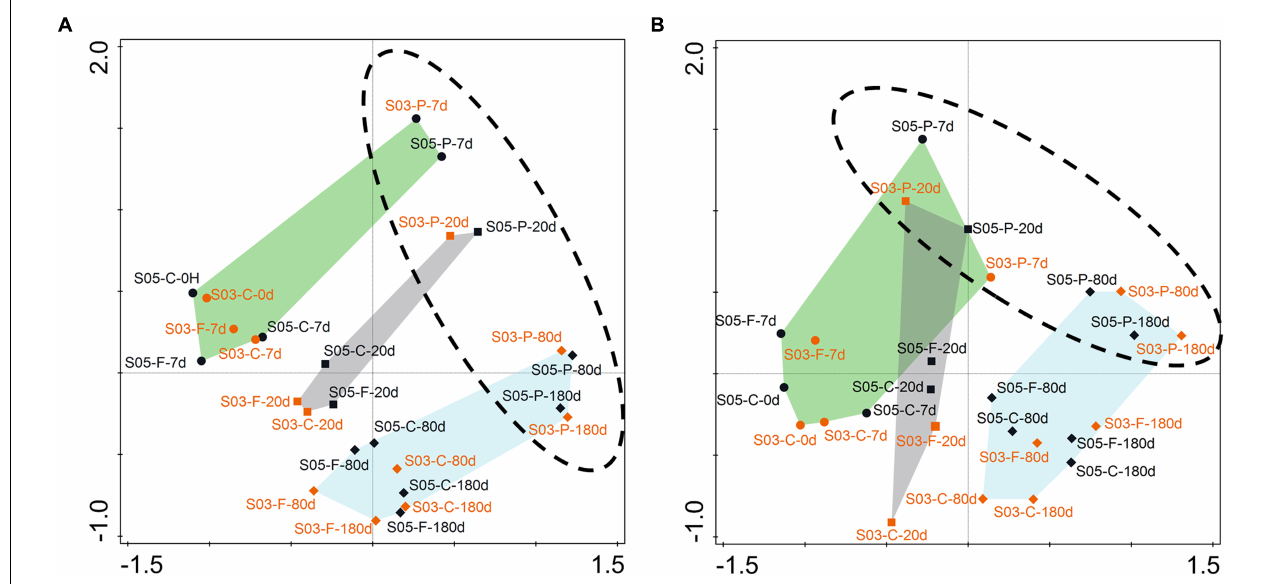
FIGURE 5 | Non-metric multidimensional scaling (NMDS) ordination based on Bray–Curtis similarities between microbial communities at the two-station incubations. (A) rDNA- based; (B) rRNA-based. Each dot represents an individual sample in the NMDS figures, S05: dark dot; S03: orange dot. C-, control; F-, 0.22–3 µ m size fraction (free-living fraction); and P-, > 3 µ m size fraction (particle-associated fraction). Phase I: indicated by the green shading; Phase II: indicated by the gray shading; and Phase III: indicated by the blue shading. The phase I contained samples from days 0 and 7; the phase II only comprised the 20th samples; and the phase III consisted of samples from days 80 and